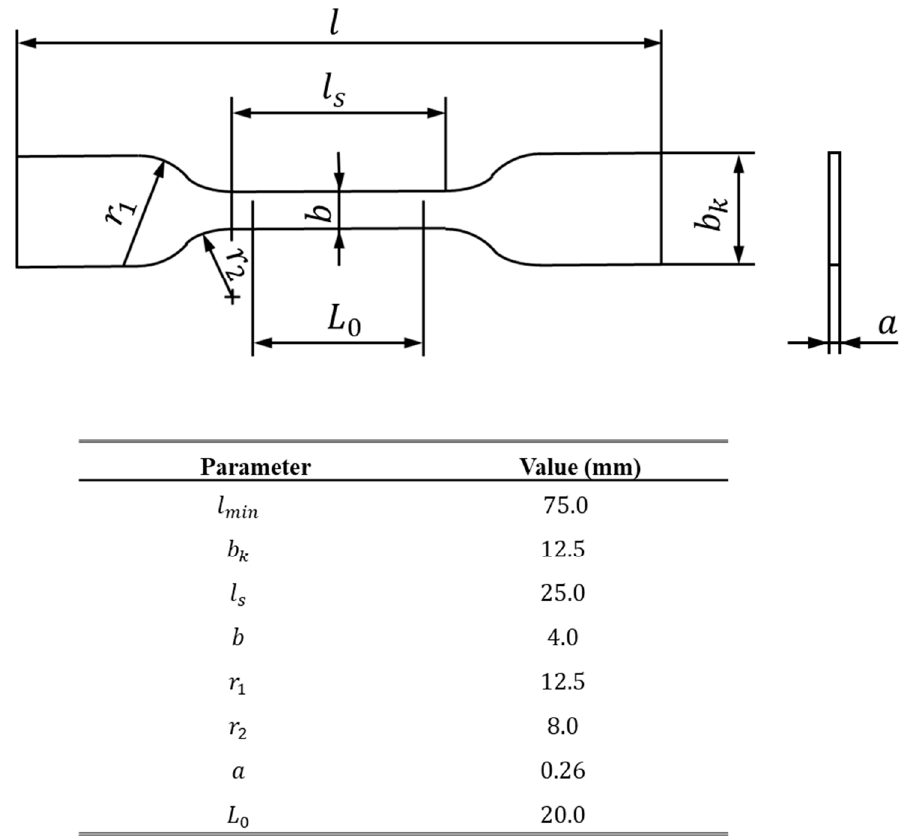
Figure 1. Bulk specimen’s geometry ( top ) and the respective values in mm ( bottom ).